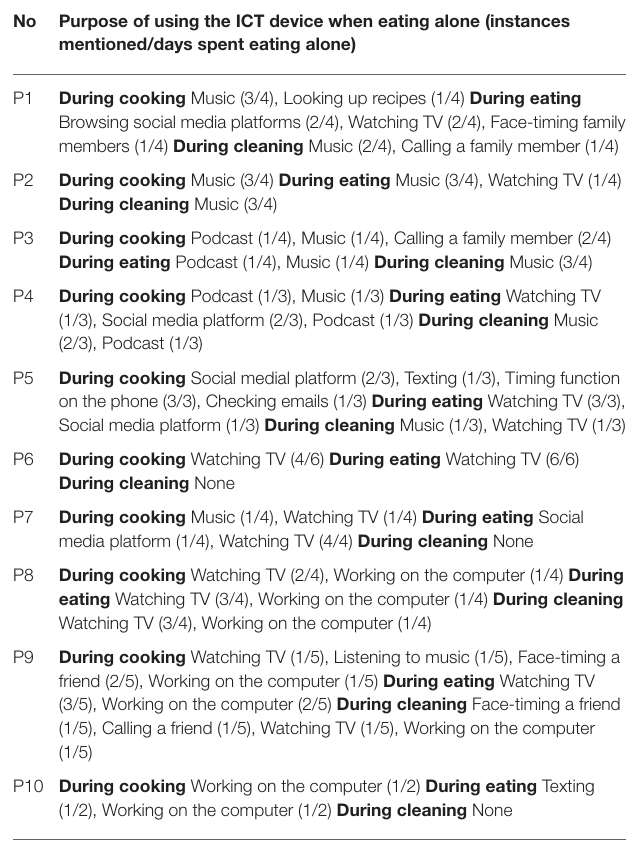
TABLE 3 | Use of ICT